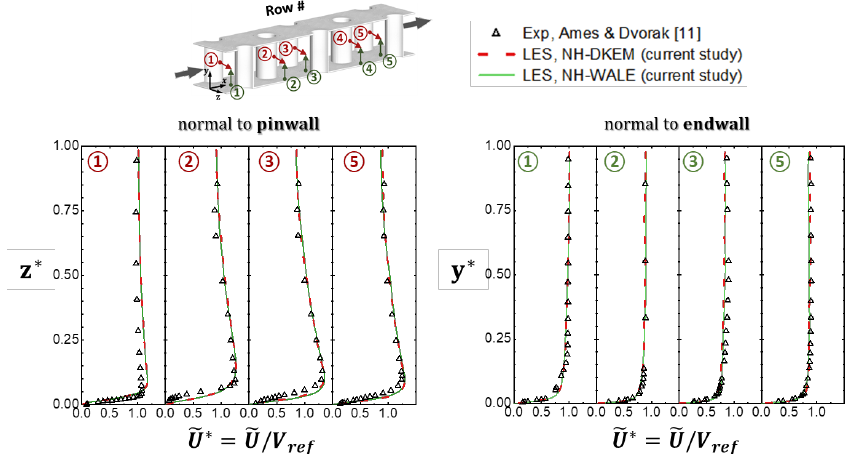
Figure 9. Measured and computed mean x-component velocity profiles with Re D = 10,000.